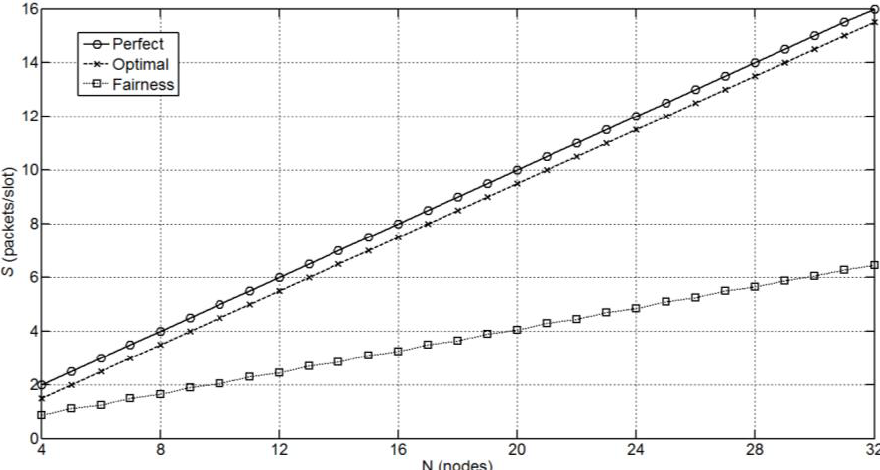
Figure 9. Throughput obtained by the optimal (cross marker) and simple fair (square marker) schedules in a 𝑁 -nodes string network. In order to compare both with the ideal limit, the throughput for a perfect schedule (circle marker) is also shown.